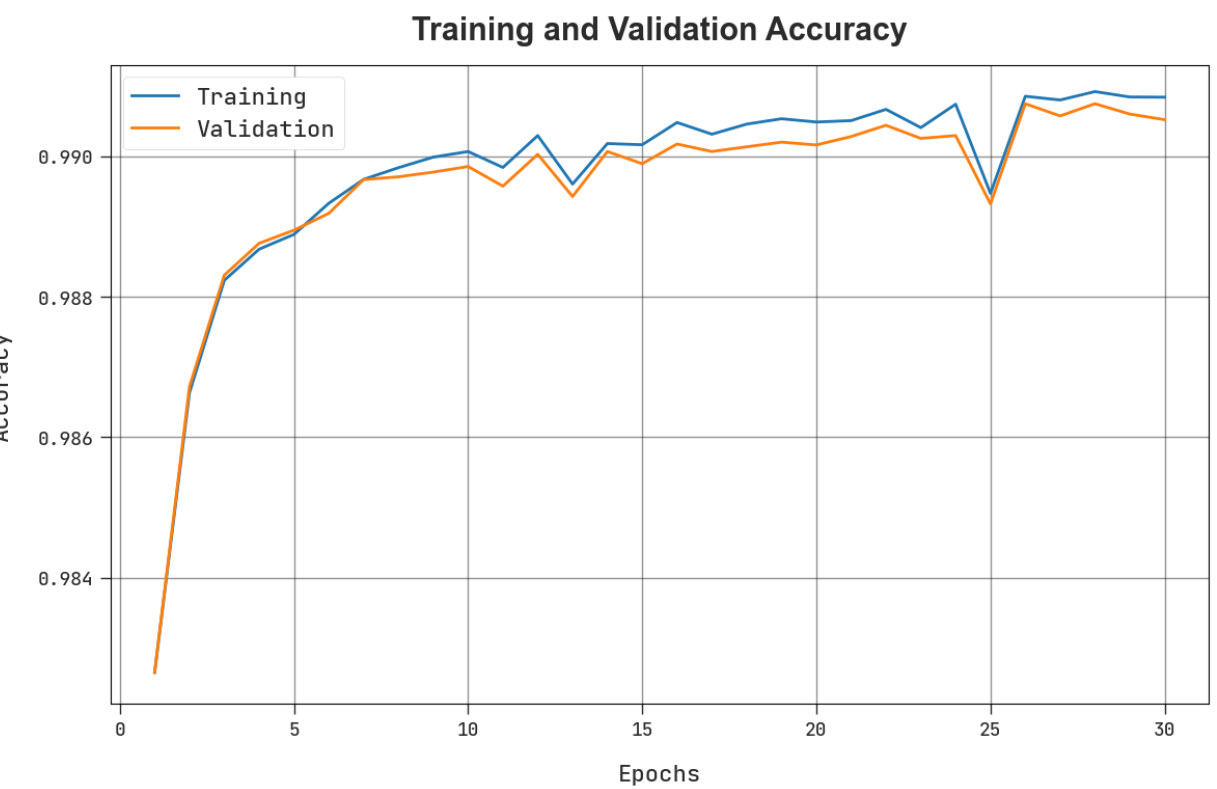
The TACY and VACY of the BCOA-MLID model were used to investigate the IoT-WSN detection performance in Figure 6. The figure shows that the BCOA-MLID model has shown improved performance with increased values of TACY and VACY. To be specific, the BCOA-MLID method has attained maximum TACY valued outcomes.